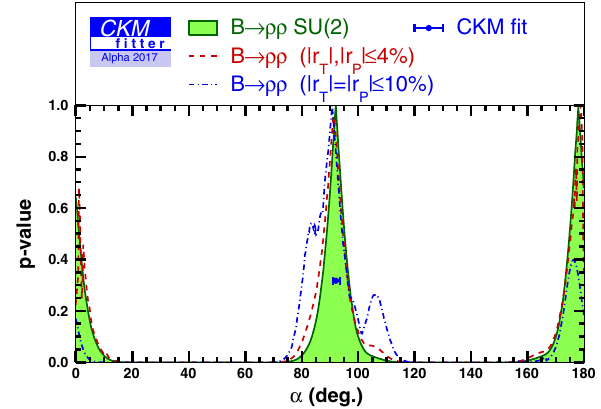
Fig. 16 Determination of α from the B → ρρ system including SU ( 2 ) -breaking amplitudes limited to 4% ( red dashed line ), limited to 10% ( blue dot-dashed line ) and neglecting this contributions ( green shaded area )